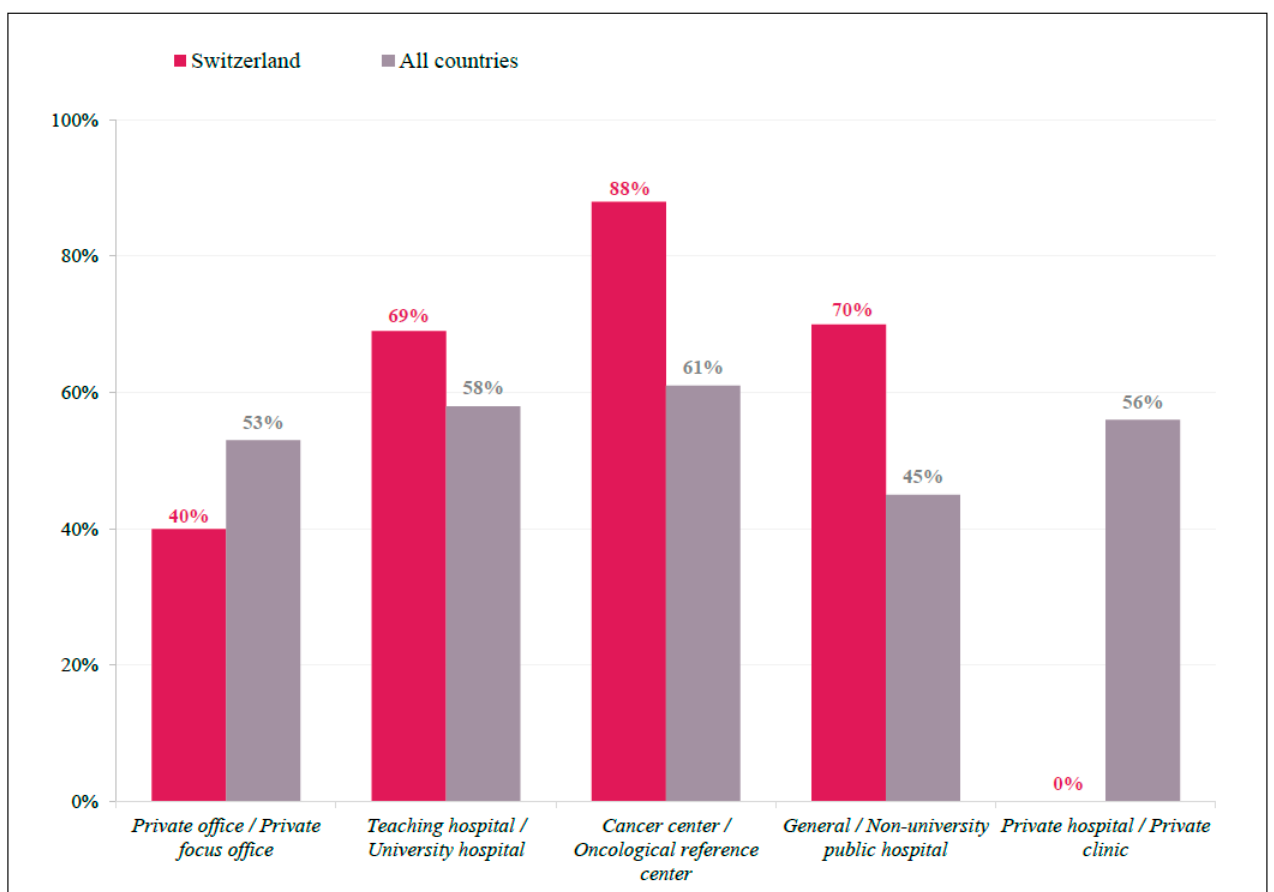
Figure 2. Tumor Sidedness by Participant Location. Bar graph representing practice demographics of respondents indicate tumor sidedness as having a ‘high impact’ on treatment decision, displayed as a percentage of total respondents for Swiss (red) and International (grey) participants.